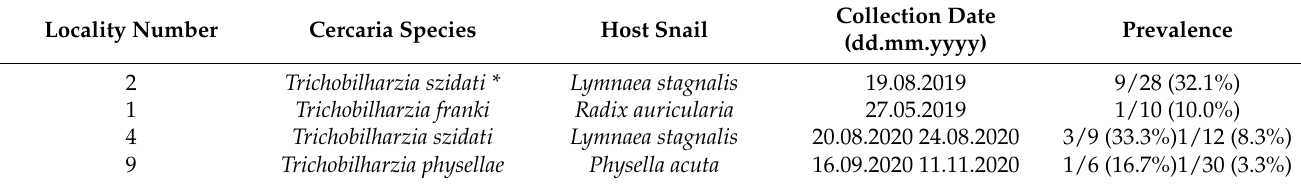
Table 6. List of Trichobilharzia species released from snails collected at four different sampling sites in the field during 2019 and 2020. The locality numbers correspond to the sampling sites in Table 1. * Trichobilharzia szidati cercaria that were only tentatively assigned due to insufficient